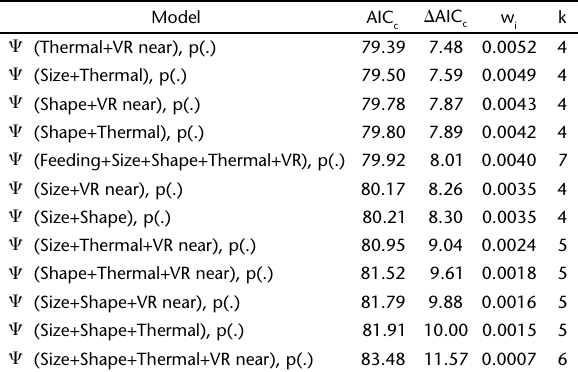
Models include different combinations of variables of VR occupation. (Feeding) Distance of VRs to Feeding sites. (Thermal) Distance of VRs to thermal power plants. “VR near” denote de distance of VRs to the nearest VR. (Shape) Shape of VR. (Size) Size of VR. (AIC Criterion corrected for small sample size; ( (cid:6) AIC Information Criterion values relative to the best model; (w a normalized likelihood of the model; (K) number of model parameters; ( (cid:4) ) Occupancy probability; (p) detection